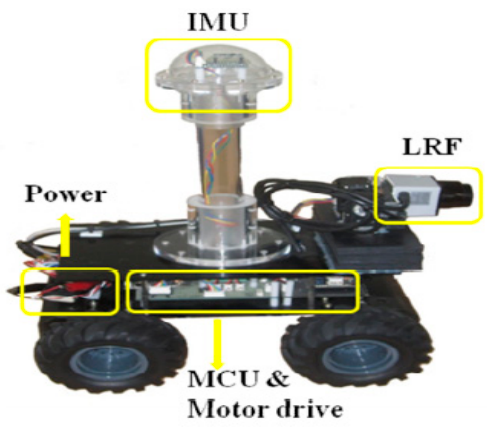
Figure 2. Structure of the mobile robot.